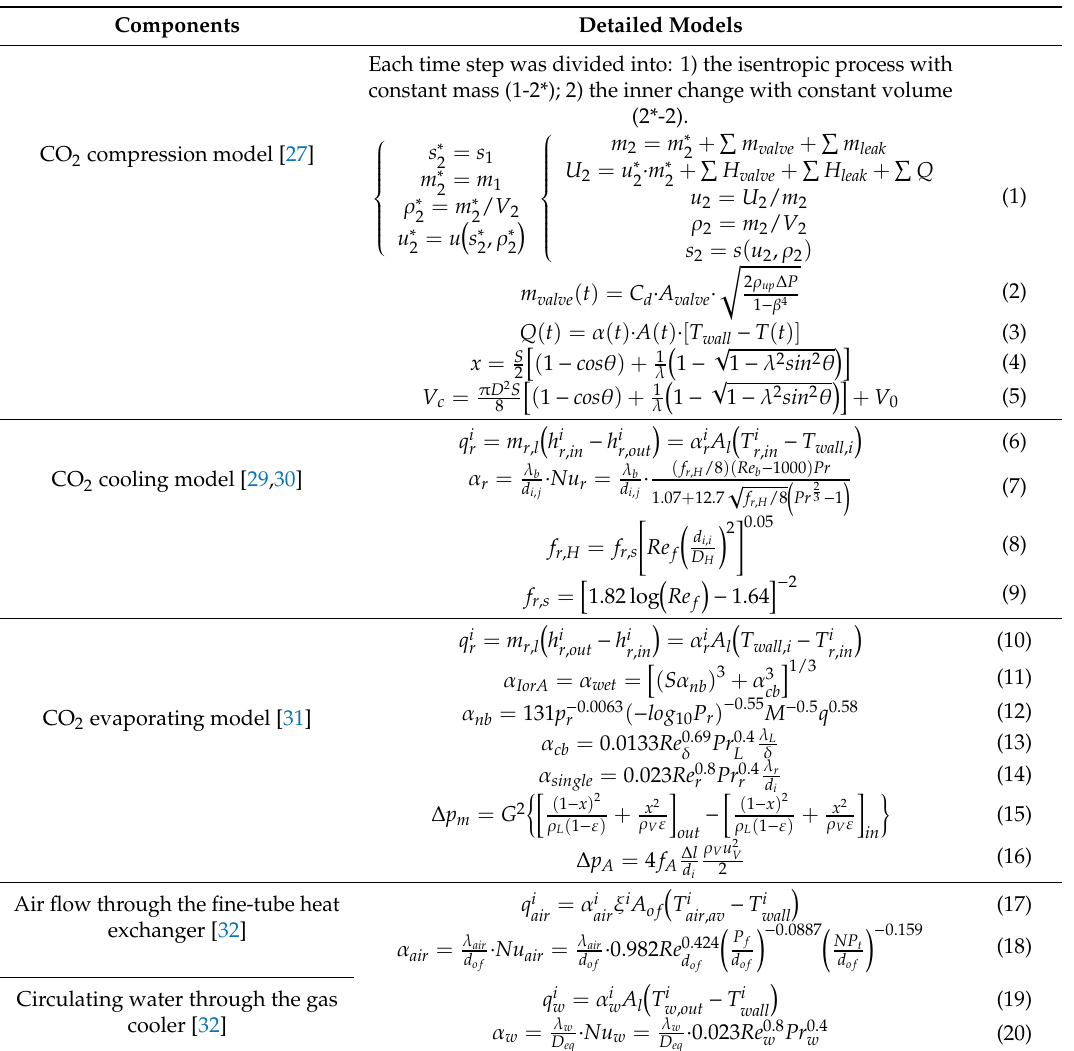
Table 1. The main equations and correlations of the component